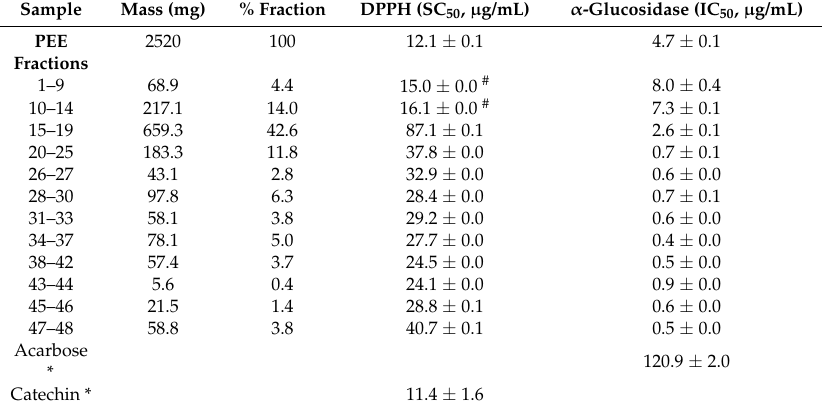
Table 4. Percent distribution of constituents in the whole PEE of G. decorticans fruits from Diego de Almagro after gel permeation (Sephadex LH-20), DPPH and α -glucosidase inhibition by the different fractions. The antioxidant effect on the DPPH discoloration assay is shown as percent inhibition at 100 µ g/mL or as SC 50 values ( µ g/mL). The inhibitory activity towards α -glucosidase is presented as IC 50 values ( µ